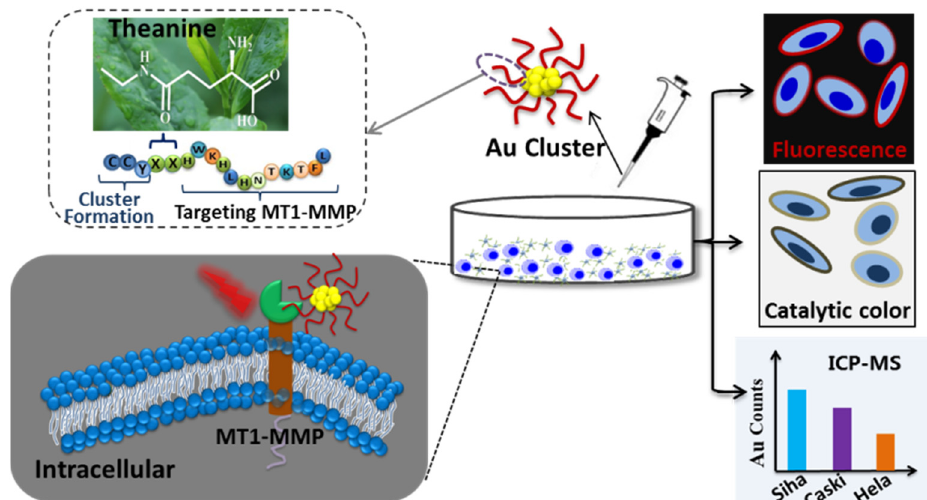
Scheme 1. Schematic illustration of the qualitative and quantitative distinction of human cervical cancer cells with different invasion/metastasis capabilities by using Au clusters.